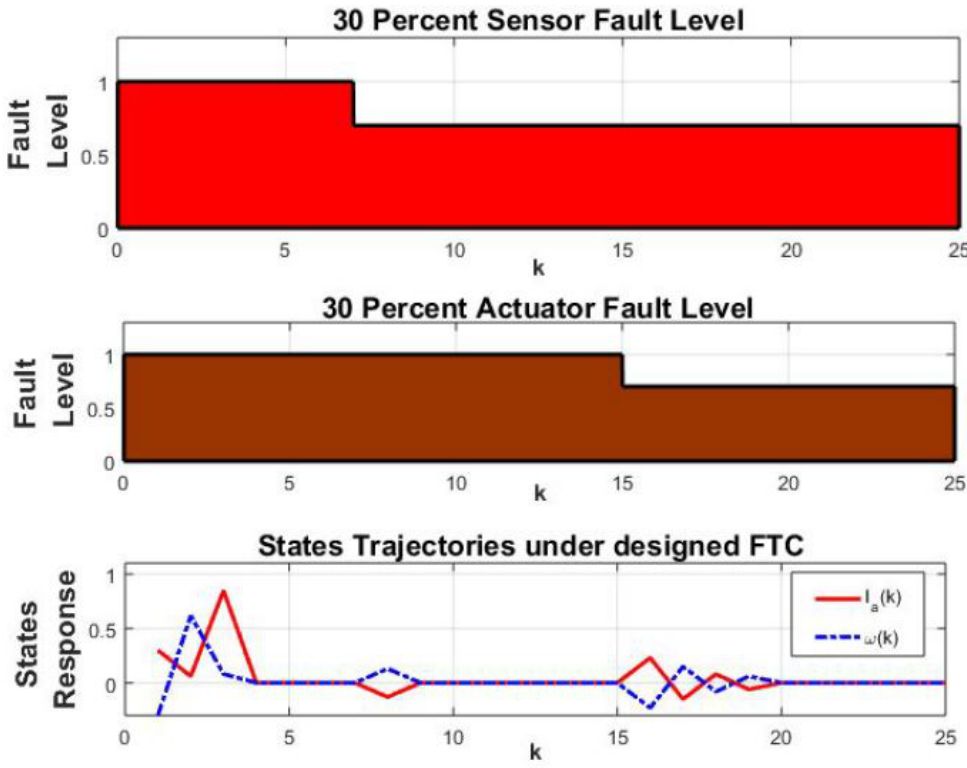
Figure 6. Tolerance of 30 percent sensor and actuator simultaneous faults.